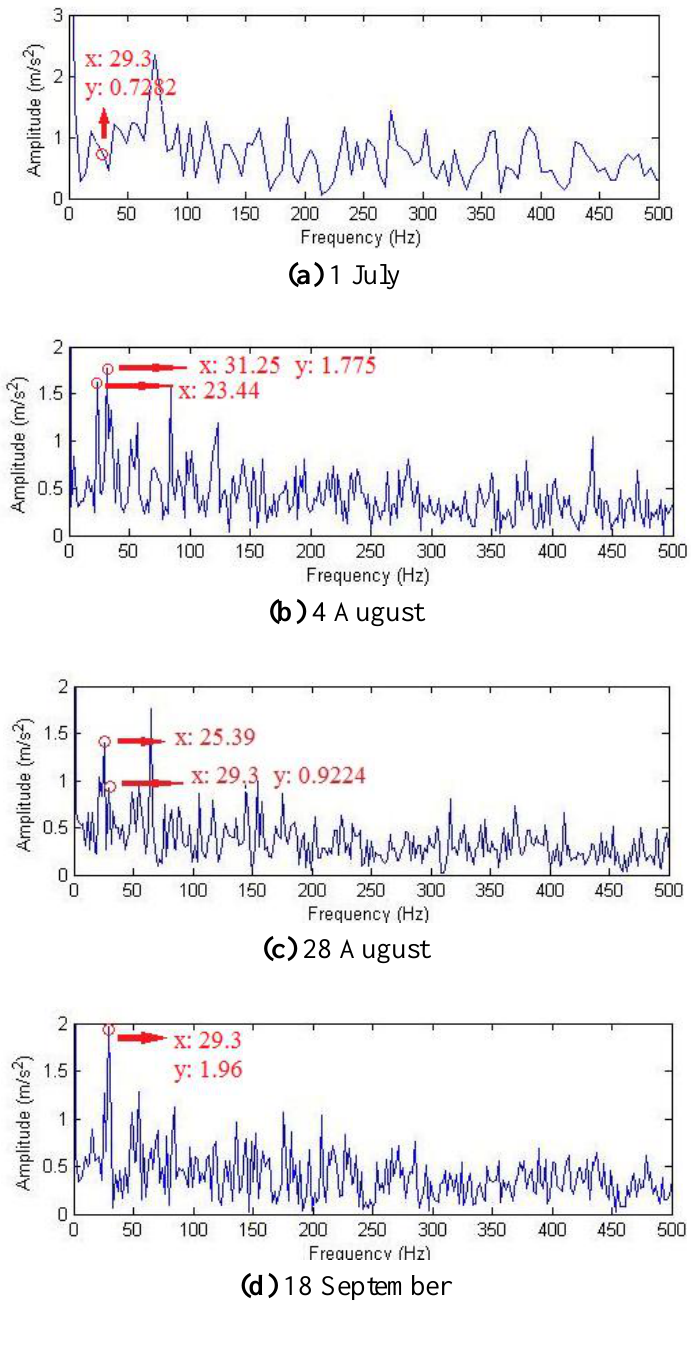
Figure 20. Demodulation spectra with single-atom